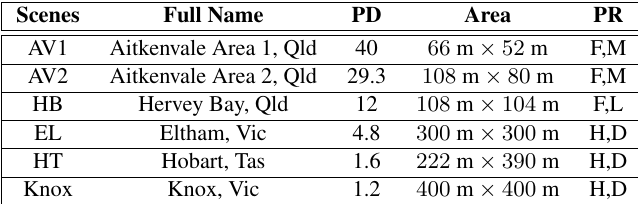
Table 1: Data sets and their basic information. PD : point